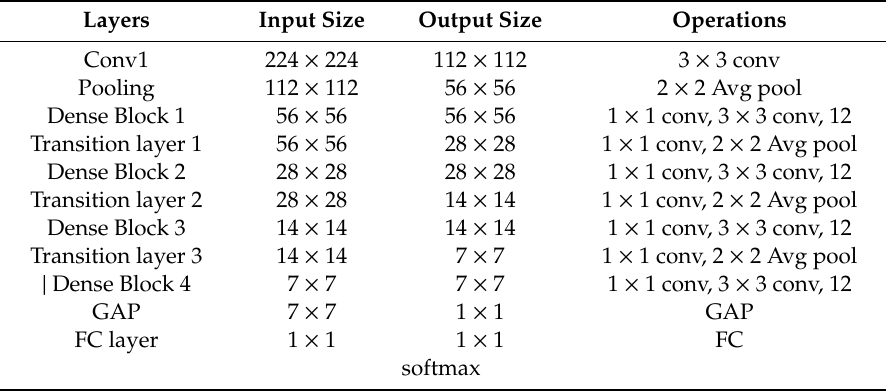
Table 1. The detailed structure of the DenseNet100